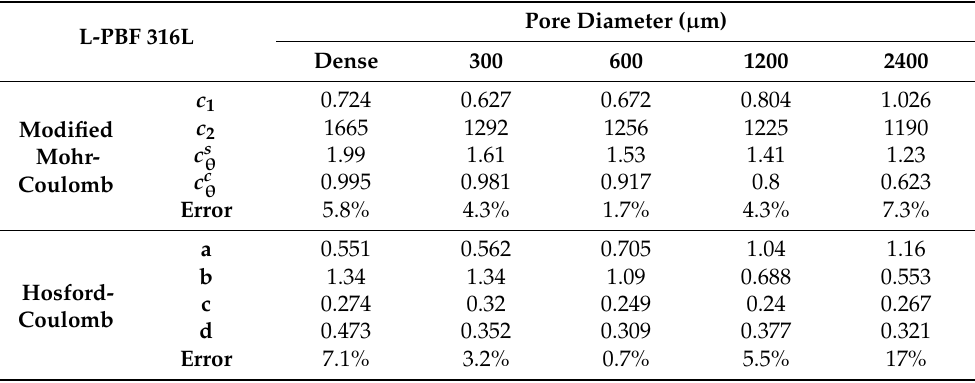
Table 3. Calibrated strain-based ductile fracture model parameters for 316L using data from dense pure shear and equibiaxial tension tests combined with dense, 300 µ m, 600 µ m, 1200 µ m, and 2400 µ m pore round notched tension Table 1. which represents perfect model agreement with